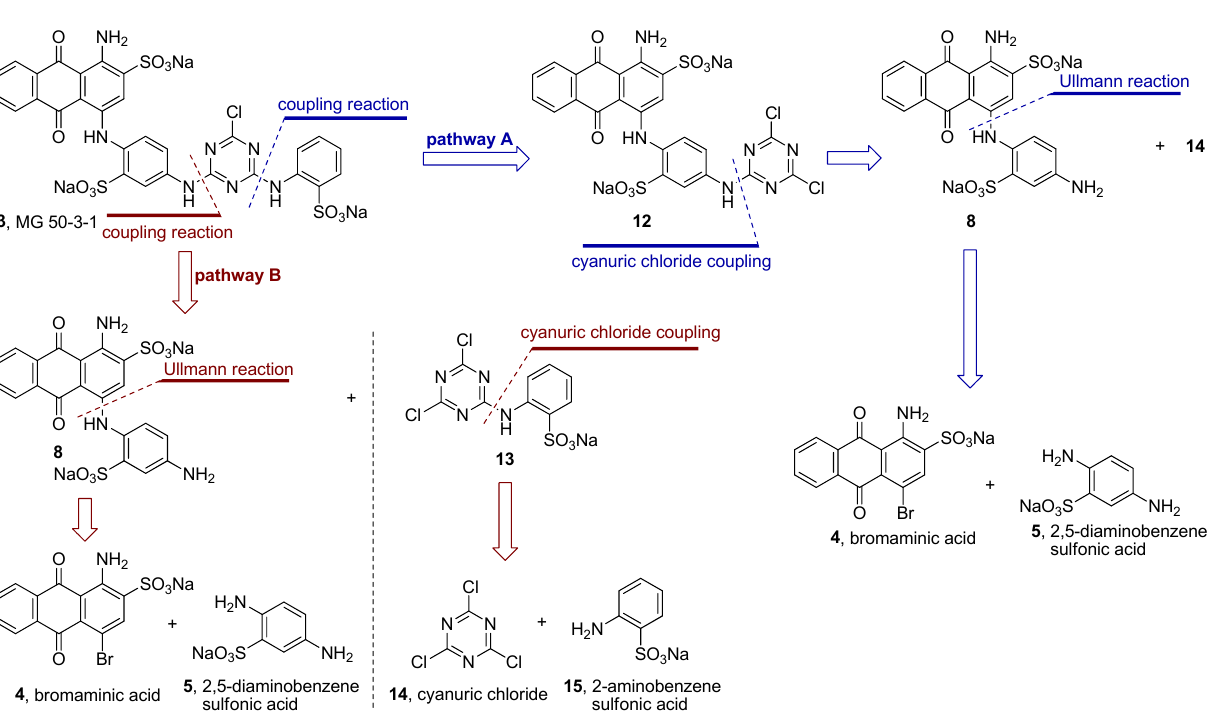
Scheme 1. Two proposed retrosynthetic analysis pathways for MG 50-3-1 ( 3 ): Linear synthesis (pathway A, blue color) and convergent synthesis (pathway B, red